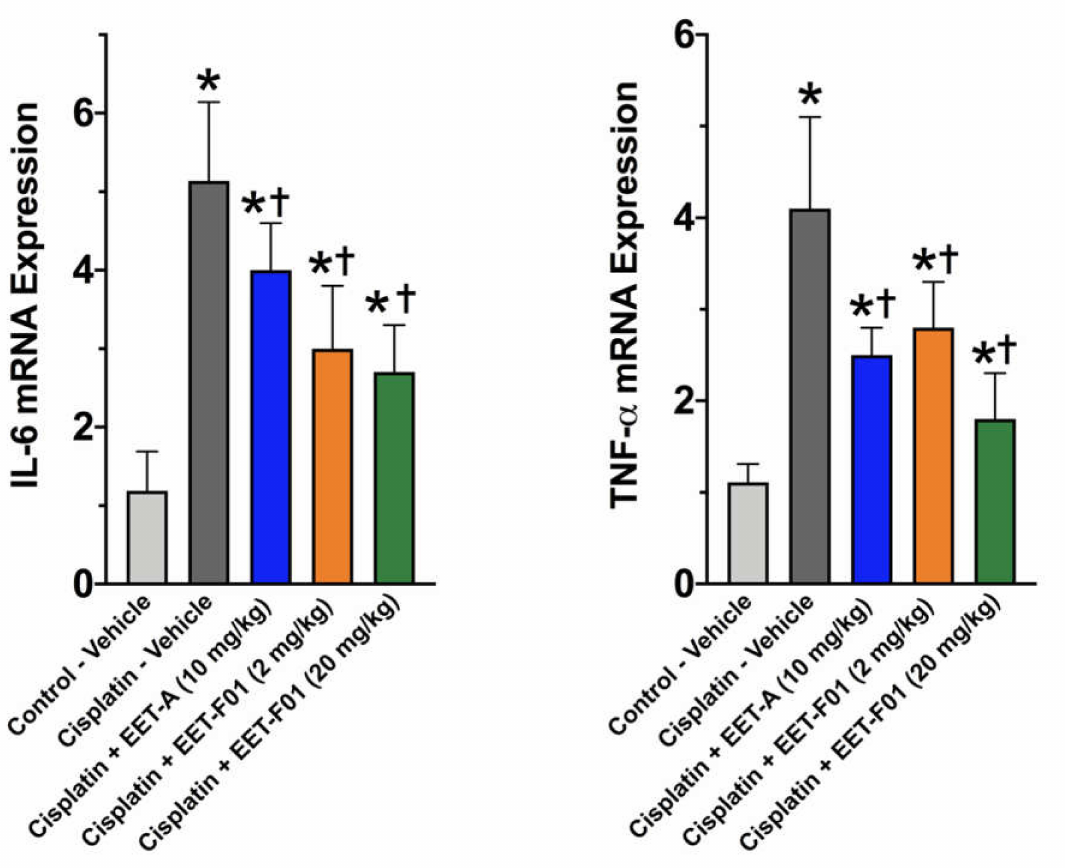
Figure 3. Renal inflammation in cisplatin nephrotoxicity is reduced by EET-F01 and EET-A treatments. RT-PCR analysis for mRNA expressions of IL-6 (left panel) and TNF α (right panel). * p < 0.05 vs. control–vehicle group; † p < 0.05 vs. cisplatin–vehicle group. Data expressed as mean ± SEM, n =